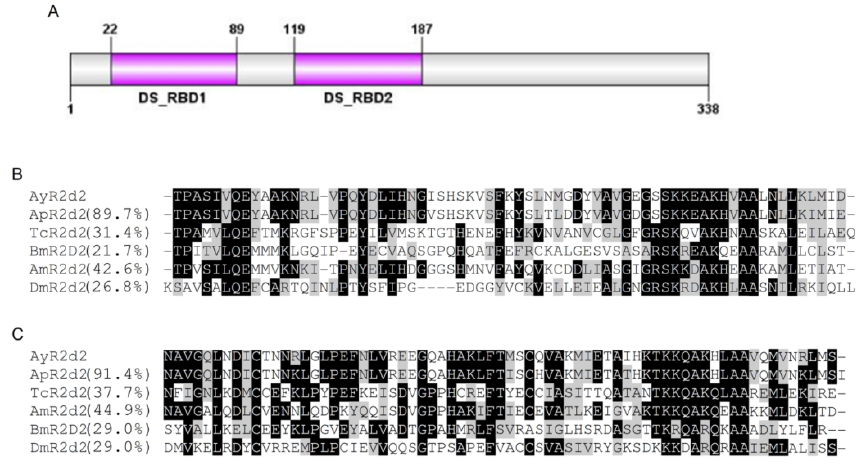
Figure 2. ( A ) Domain architecture of R2d2 in A. glycines . Both DS_RBD1 and DS_RBD2 domains are indicated; ( B ) and ( C ) Multiple sequence alignment of DS_RBD1 ( B ) and DS_RBD2 ( C ) domain sequences from insect R2d2 proteins. The conserved and similar amino acid residues are labeled in black and grey backgrounds respectively. The figures in the parentheses indicate the percent identity to the respective domain of AyR2d2. R2d2